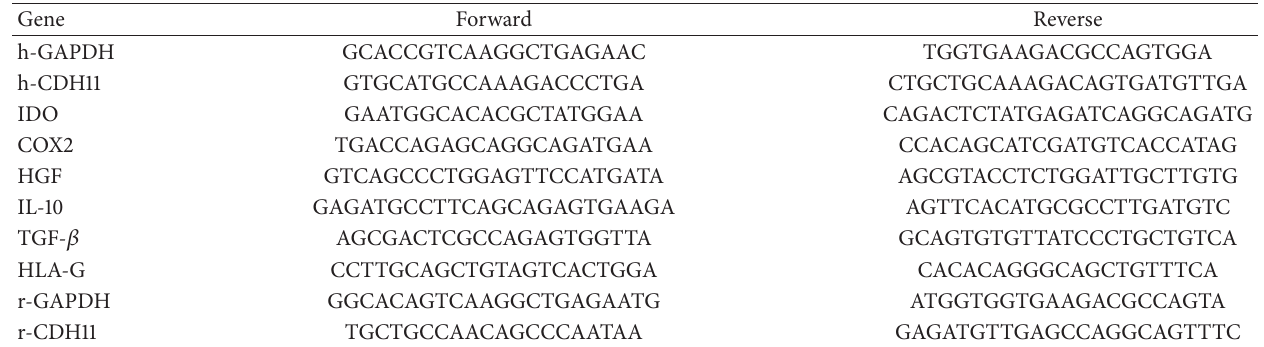
Table 1: Primers for real-time